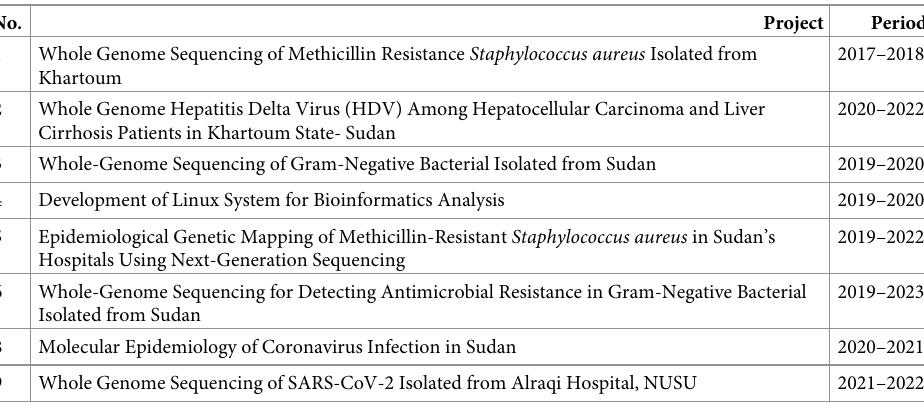
Table 3. Major projects conducted at NUBRI (all are funded by the